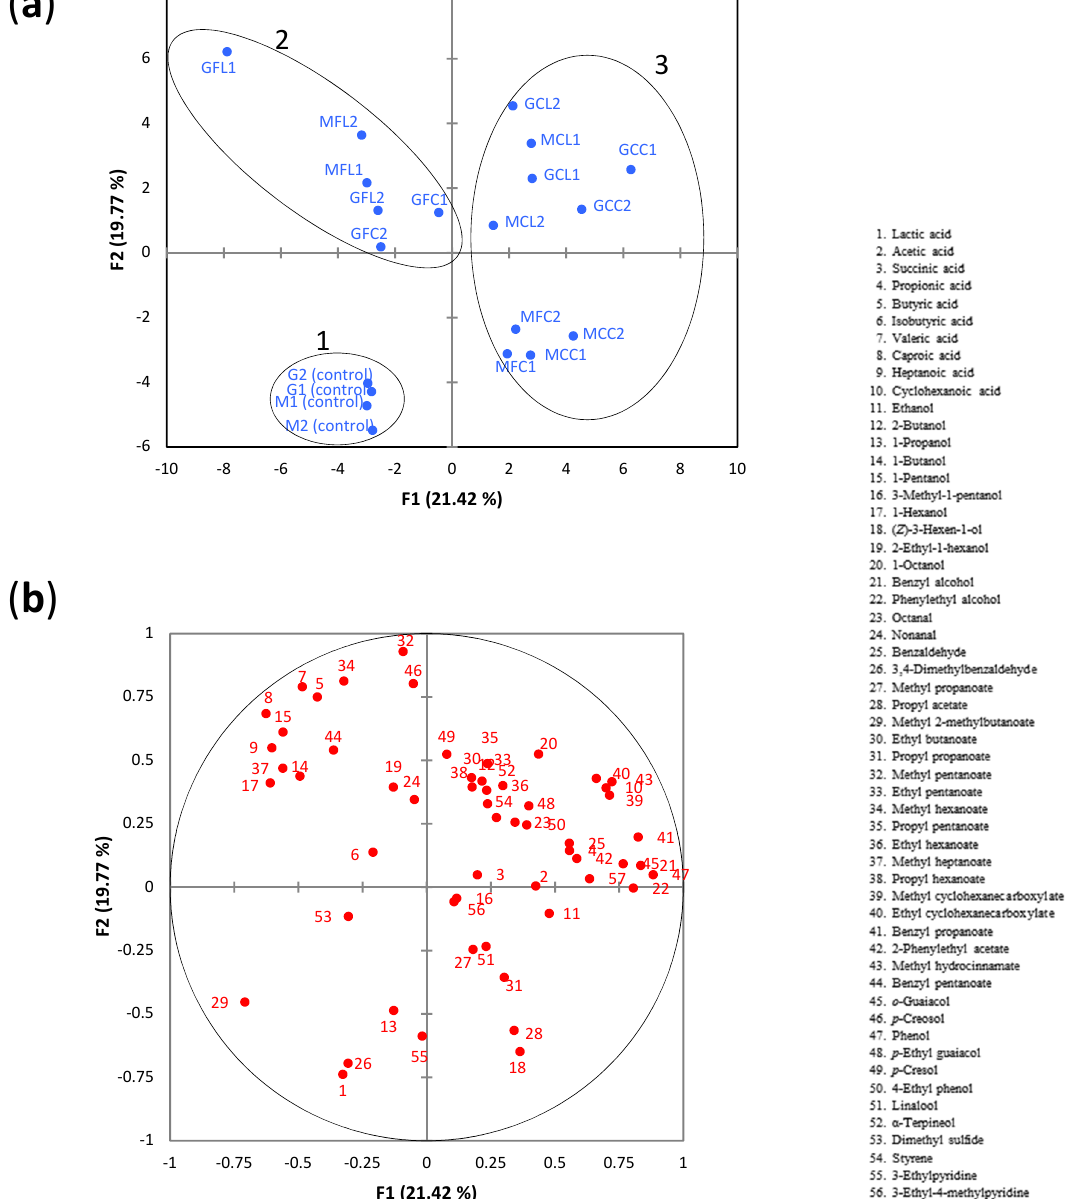
Figure 5. ( a ) The PCA score plot of metabolite data, ( b ) the PCA loading plot of metabolite data. The 3 groups identified by agglomerative hierarchical cluster (AHC) analysis are highlighted by ellipses. See Table 5 for the meanings of samples abbreviations.